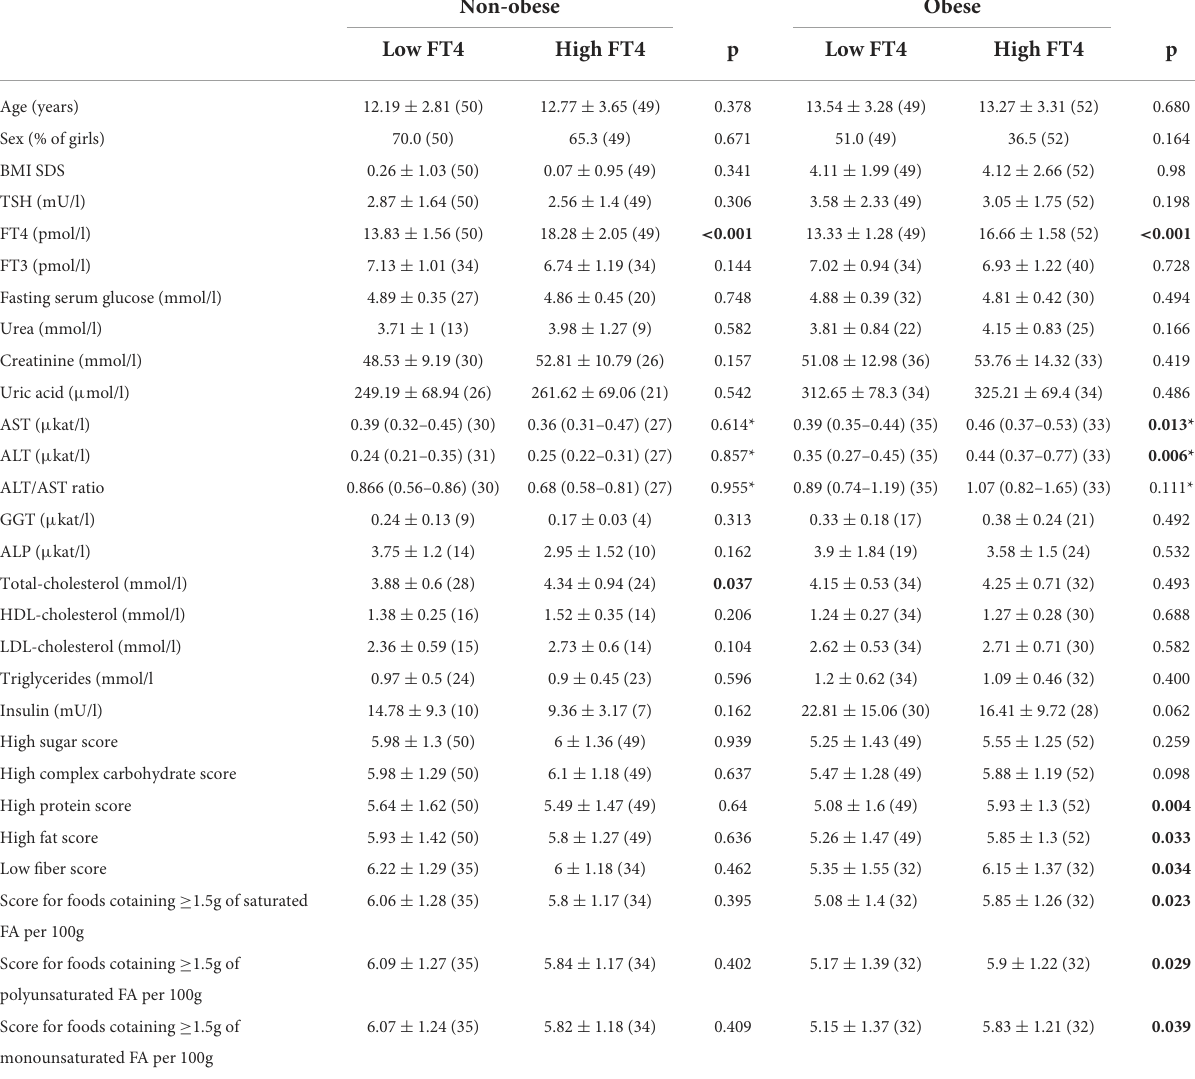
TABLE 2 Selected phenotypes in children and adolescents stratified according to FT4 serum